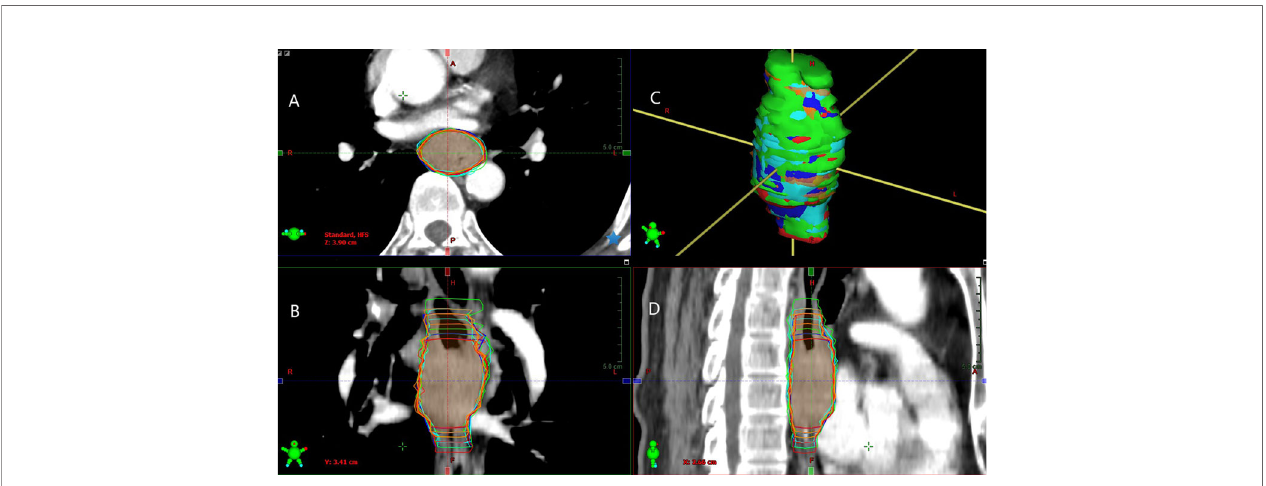
FIGURE 1 | Example of GTVs delineated based on different combinations of multimodal images by observer 1 (green segment), observer 2 (red segment), observer 3 (blue segment), observer 4 (orange segment), and observer 5 (cyan segment) in tansversal (A) , frontal (B) , surface (C) , and sagittal (D) planes for one patient (Patient 5). Inter-/intra-observer variability in the volume and longitudinal length on different combinations of multimodal images exhibiting signi fi cant